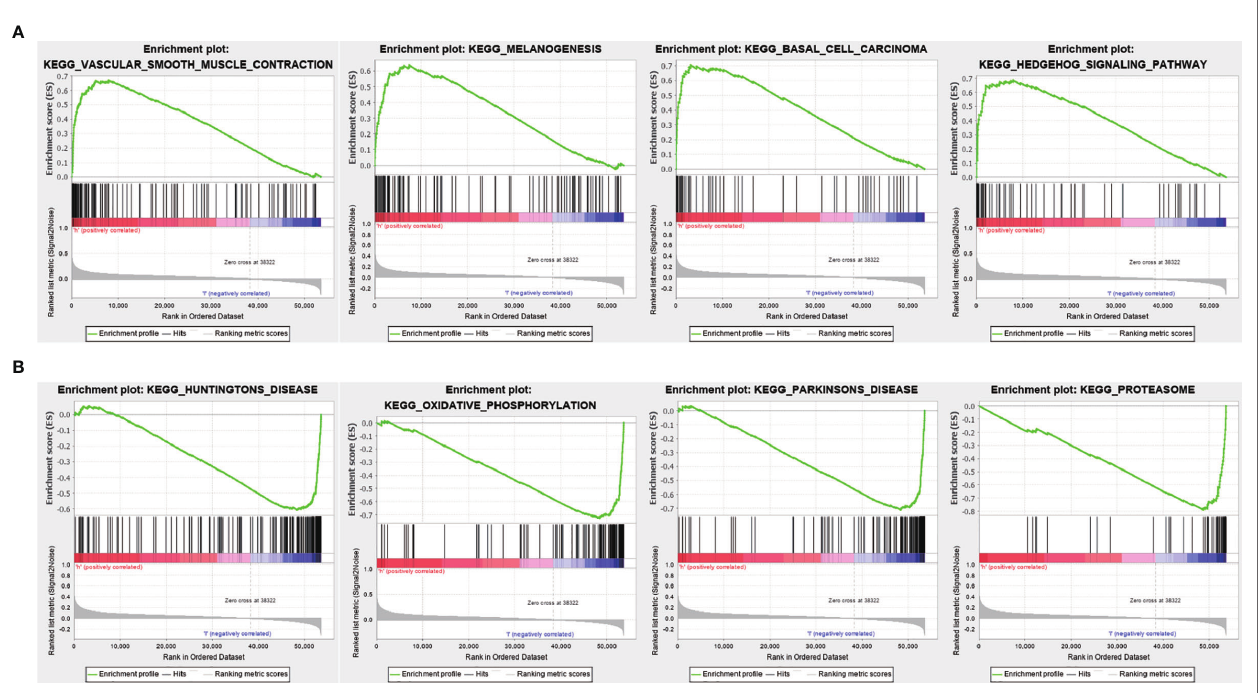
FIGURE 8 | Gene set enrichment analysis (GSEA) based on fetal-lethal non-coding developmental regulatory RNA (FENDRR) expression. (A) Association of FENDRR expression with vascular smooth muscle contraction, melanogenesis, and basal cell carcinoma pathways. (B) Association of FENDRR expression with Huntington ’ s disease, oxidative phosphorylation, and other